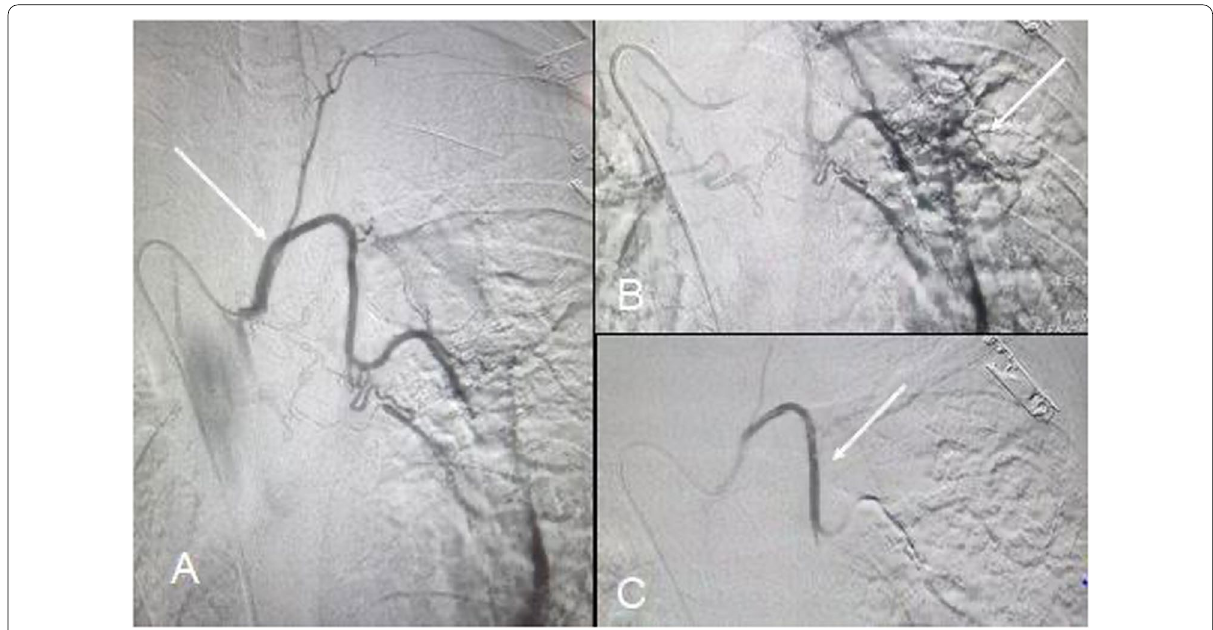
Fig. 2 A Digital subtraction angiography (DSA) image in arterial phase showing left intercosto-bronchial trunk (white arrow) with hypertrophied left bronchial artery and normal first intercostal artery. B Digital subtraction angiography (DSA) image in parenchymal phase showing marked parenchymal blush in region of left upper zone (white arrow). C Digital subtraction angiography (DSA) image after embolization with PVA particles shows complete disappearance of parenchymal blush